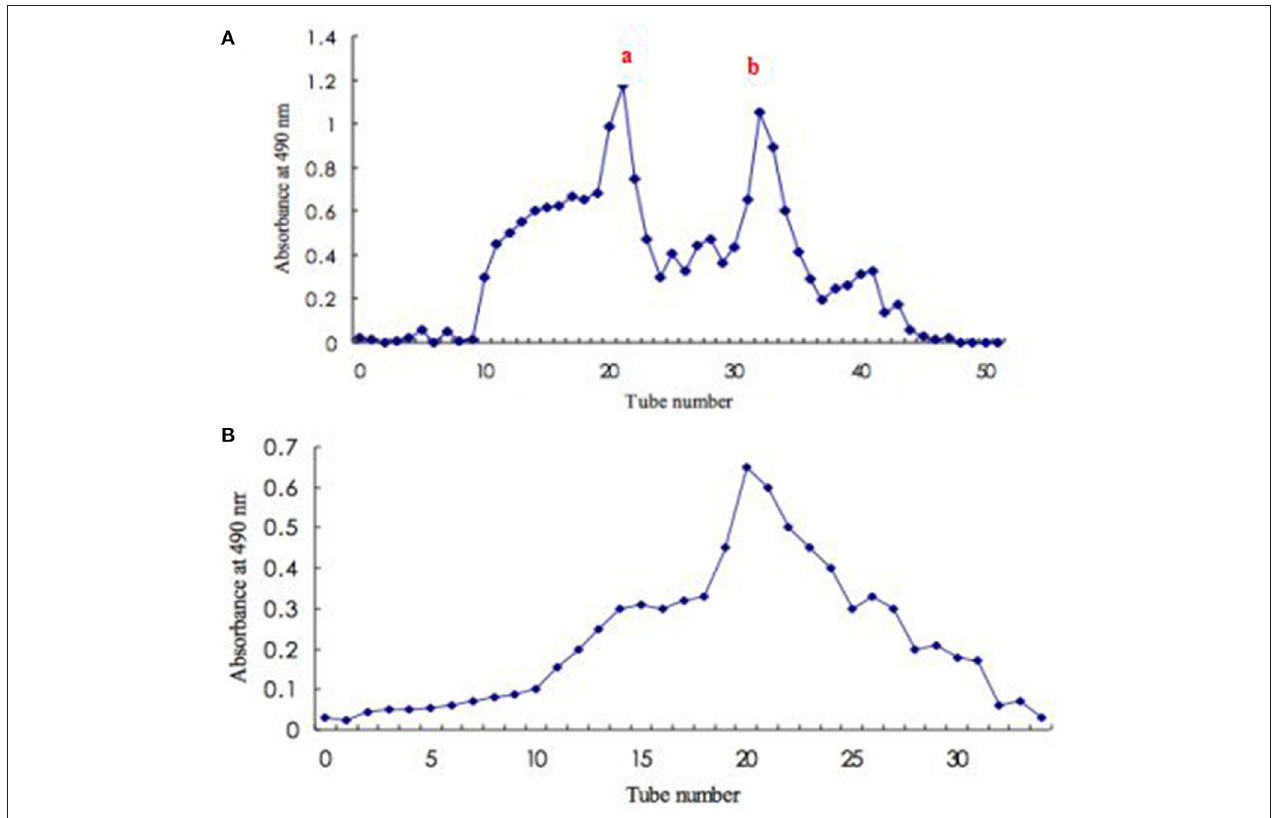
FIGURE 1 | Isolation and purification of exopolysaccharide from S. commune . (A) Elution profile (fraction a and fraction b) of crude polysaccharide on DEAE-52 anion-exchange column; (B) Elution profile to fraction a on Sephadex G-150 gel filtration column.